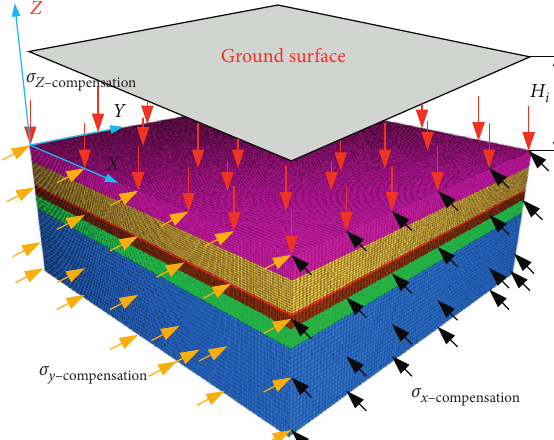
Figure 3: Schematic diagram of the experimental model’s self- weight stress and compensation stress.